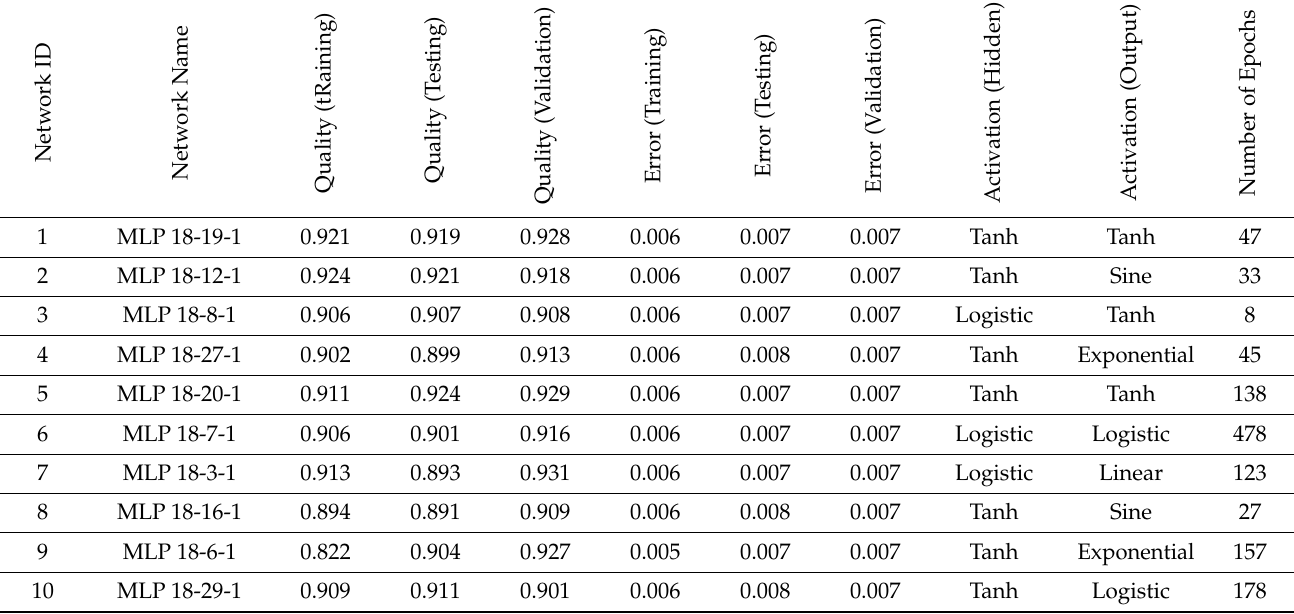
Table 1. List of parameter values of 10 neural networks with the smallest prediction error